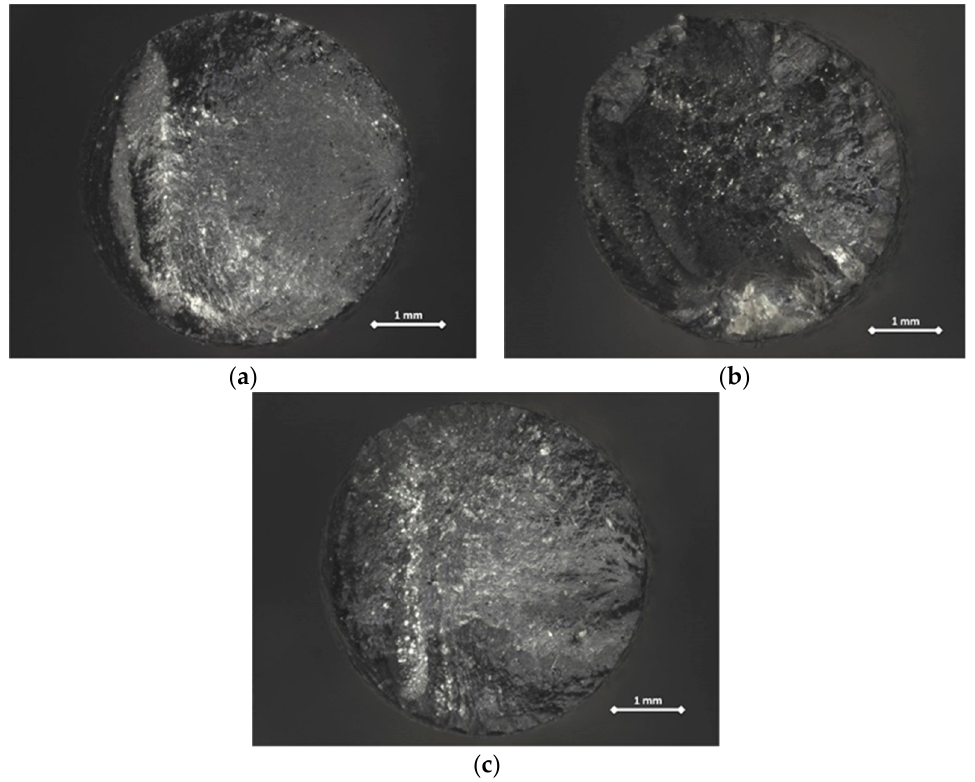
Figure 6. Fatigue fracture surfaces of three specimens under different loading amplitudes: ( a ) MS1_AN_PLATF_5_Pr004; ( b ) MS1_AN_PLATF_5_Pr012; ( c ) MS1_AN_PLATF_5_Pr015.